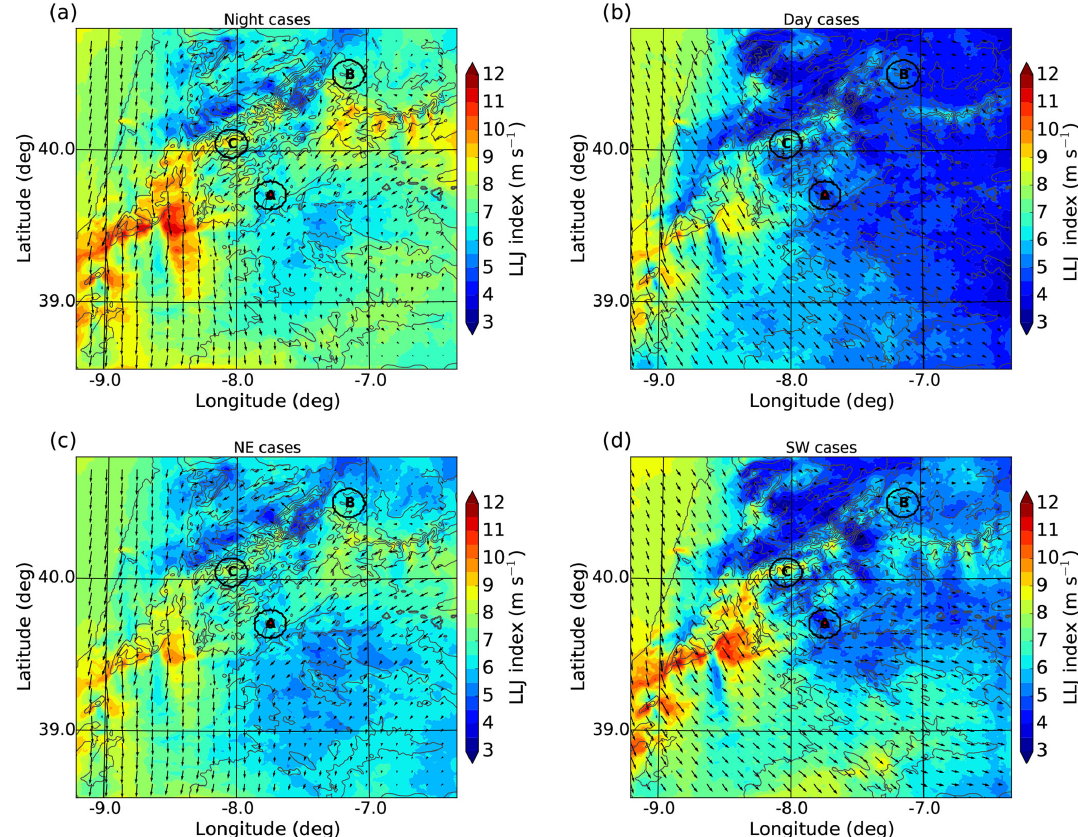
Figure 10. Temporal average of the LLJ index for the period 1 May to 15 June 2017. LLJs are detected by comparing wind speeds at 300 and 2000ma.g.l. during (a) nighttime (21:00 to 09:00UTC) and (b) daytime (09:00 to 21:00 UTC). In panels (c) and (d) , only cases with wind directions from the NE (negative cross-valley winds) and SW (positive cross-valley winds) at 300ma.g.l. at the location of the WT were used. Arrows show the mean wind field at 300ma.g.l. during (a) nighttime, (b) daytime, (c) NE and (d) SW LLJ cases. Wind vectors are plotted on every 10th grid point. Areas marked by black circles and letters A to C indicate regions used for the computation of pressure and temperature gradients in cross- and along-valley directions (see text). Region A is centred at the location of the WT. The topography is indicated with thin black contour lines. Data are based on WRF domain